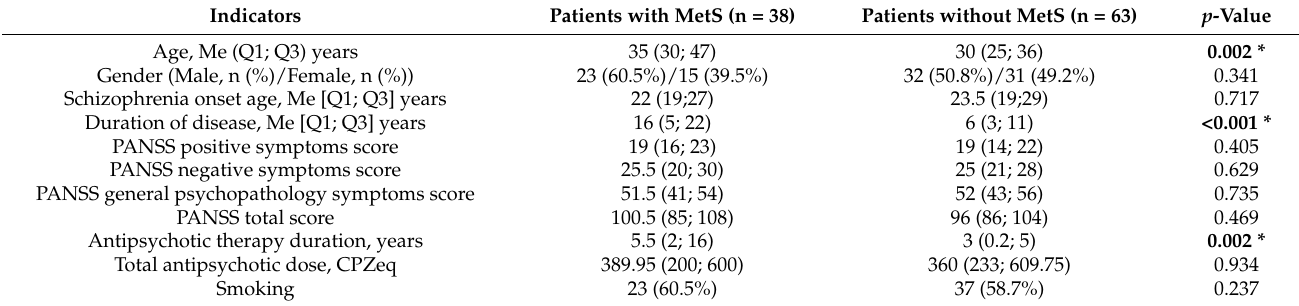
Table 1. Sociodemographic, clinical and pharmacological characteristics of patients with schizophrenia, depending on the presence of